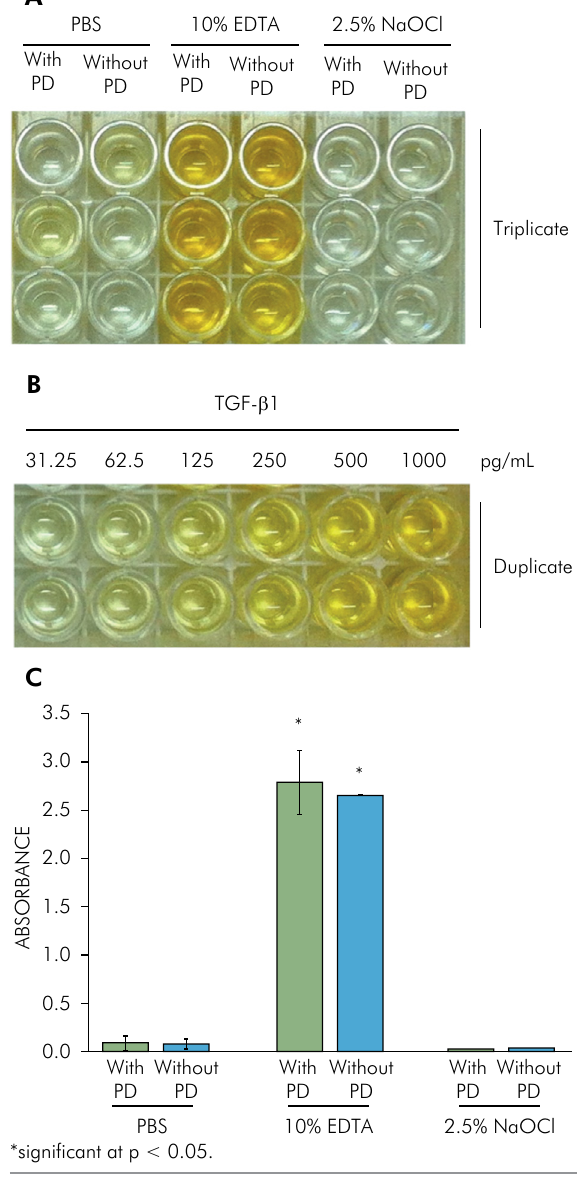
Figure 2. Enzyme-linked immunosorbent assay (ELISA) for detection of TGF-b1. A) TGF-b1 released in the culture medium by tooth slices either containing or not containing the predentin layer (PD) and treated with PBS, 10% EDTA or 2.5% NaOCl, B) compared with serially diluted TGF-b1 antibody. C) Optical density at 450 nm measured on an ELISA reader for detection of TGF-b1 released in the culture medium by tooth slices either containing or not containing the predentin layer (PD) and treated with PBS, 10% EDTA or 2.5%